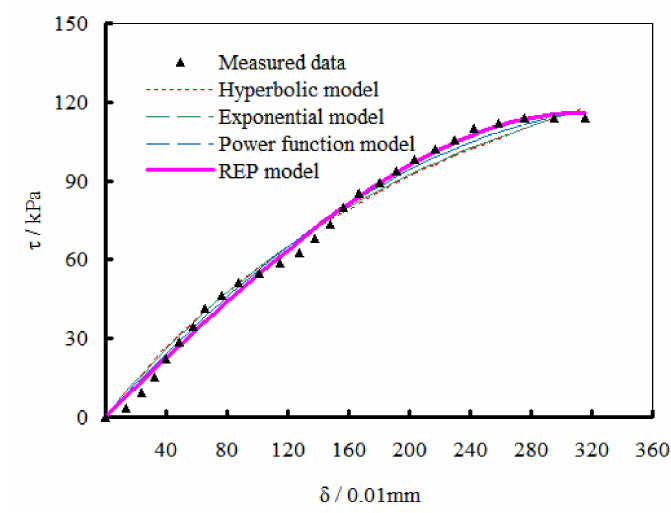
Figure 5. τ - δ curve for mix ratio with 5% cement content.